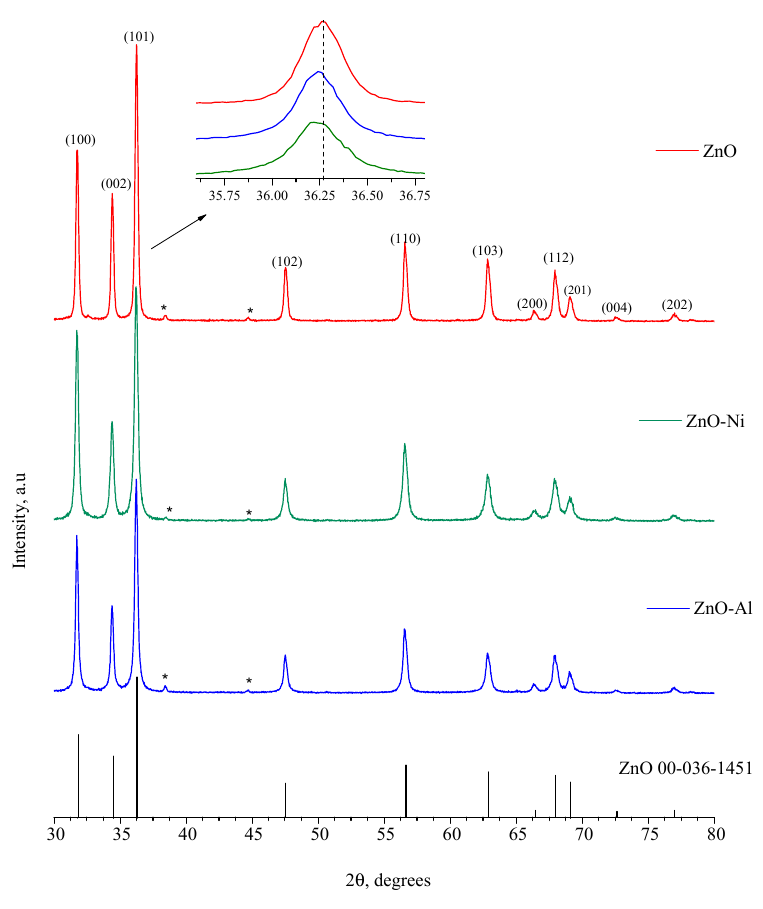
Figure 1. XRD powder patterns of ZnO and doped ZnO (Al 3+ and Ni 2+ ). Powder Diffraction File (PDF) of hexagonal (00-0361451). The inset shows the broadening and decrease of the main peak (101). The inset in Figure 1 shows the main peak (101), where we can observe a shift towards lower angles and decreased-intensity peaks due to an increased microstrain induced by the presence of foreign ions [25]. Kaneva et al. report variation of the FWHM due to the presence of Ni 2+ affecting the crystallization process by inhibiting the aggregation of the ZnO nanocrystals [26]. Similarly, Yadav et al. reported that the peak broadening is attributed to stress or particle size variation due to the presence of other atoms in the network [27]. Theoretically, since the ion radii have a coordination number of 4 (tetragonal site), Al 3+ (0.053 nm) and Ni 2+ (0.069 nm) radii are smaller than those of Zn 2+ (0.074 nm) [28,29]. Therefore, it is easy for Al 3+ and Ni 2+ ions to substitute for Zn 2+